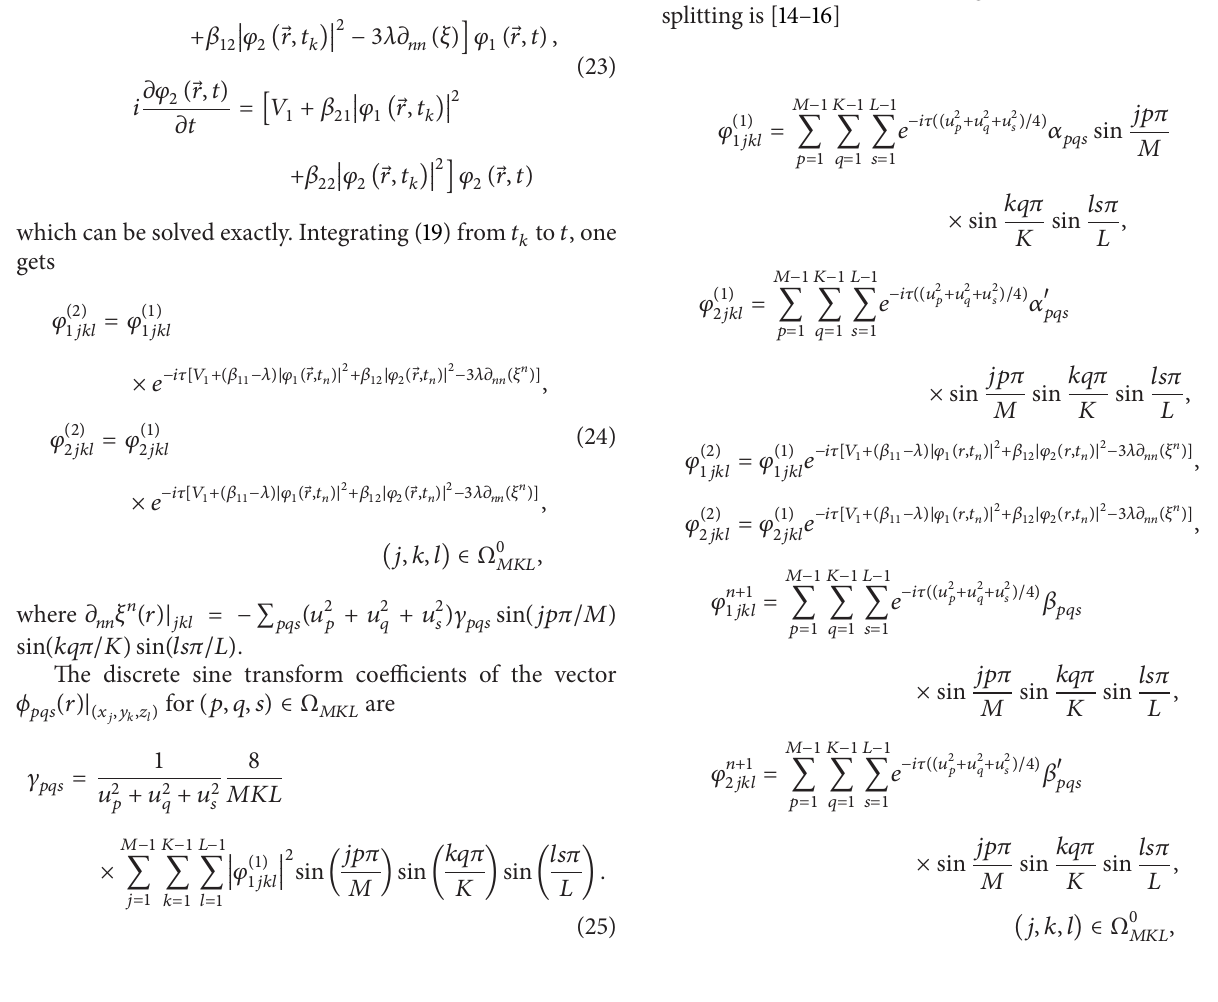
Substituting (22) into (13), we get a linear